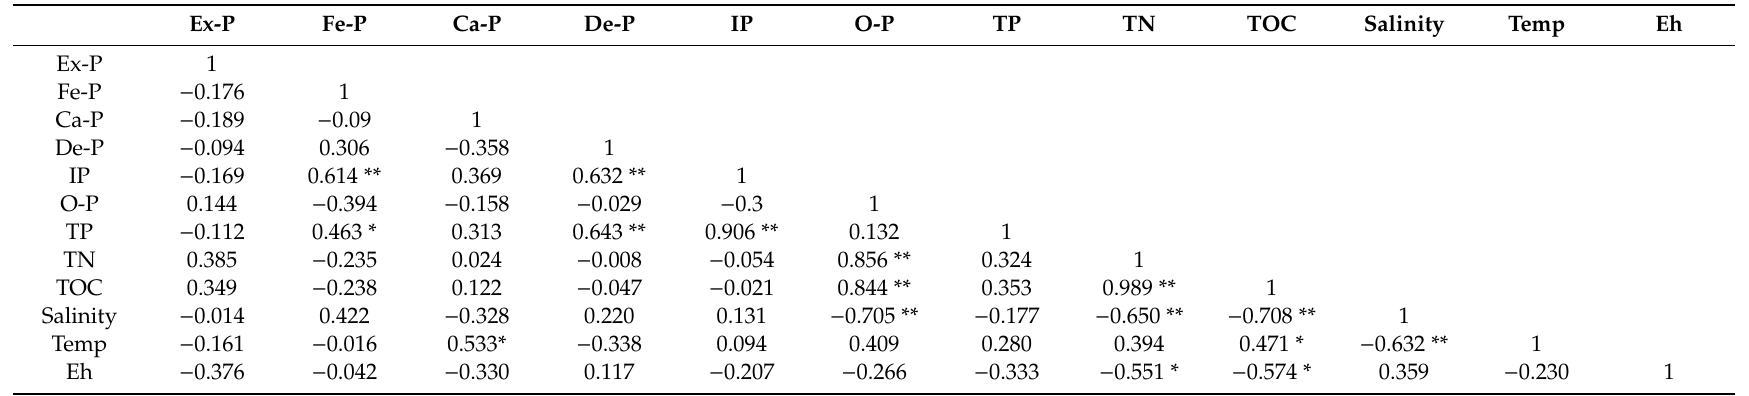
Table 3. Pearson correlation (PC) coe ffi cient matrix of di ff erent P fractions, total nitrogen (TN), and total organic content (TOC) in the surface sediments of Daya